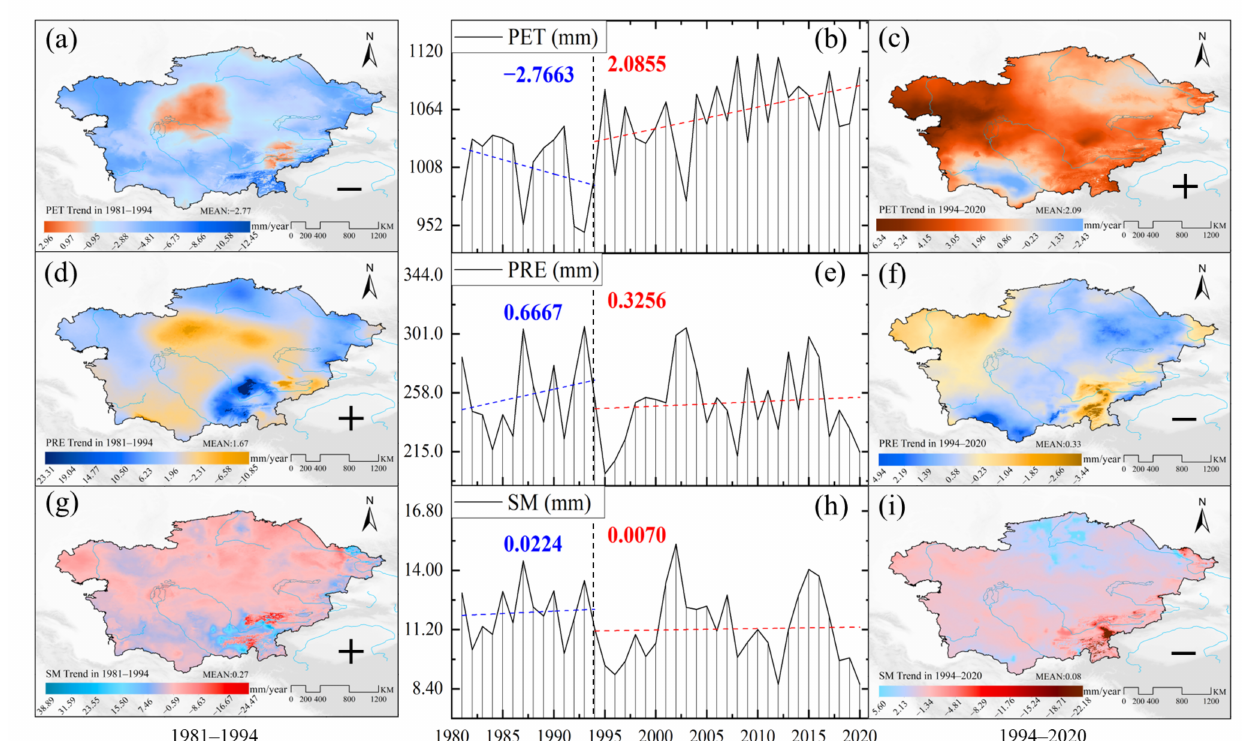
Figure 6. Temporal and spatial trends of PET, PRE, and SM: 1981–1994: ( a ) PET, ( d ) PRE, and ( g ) SM; 1994–2020: ( c ) PET, ( f ) PRE, and ( i ) SM; for 1981–2020: Segmentation time trends in ( b ) PET, ( e ) PRE, and ( h ) SM before and after 1994,